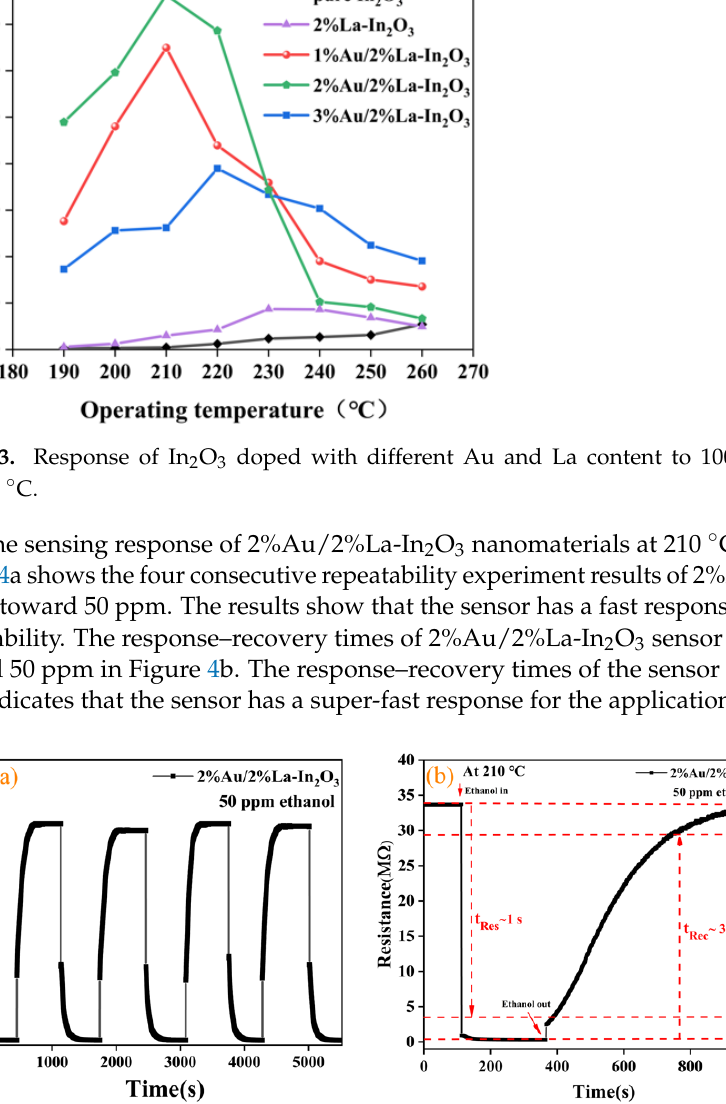
Figure 4. Response of 2%Au/2%La-In 2 O 3 sensor to the same concentration of ethanol ( a ) and different concentrations of ethanol ( b ) at optimum operating temperature.